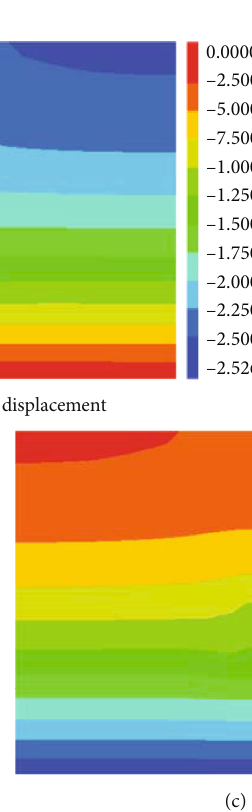
Figure 18: Horizontal stress cloud after support.